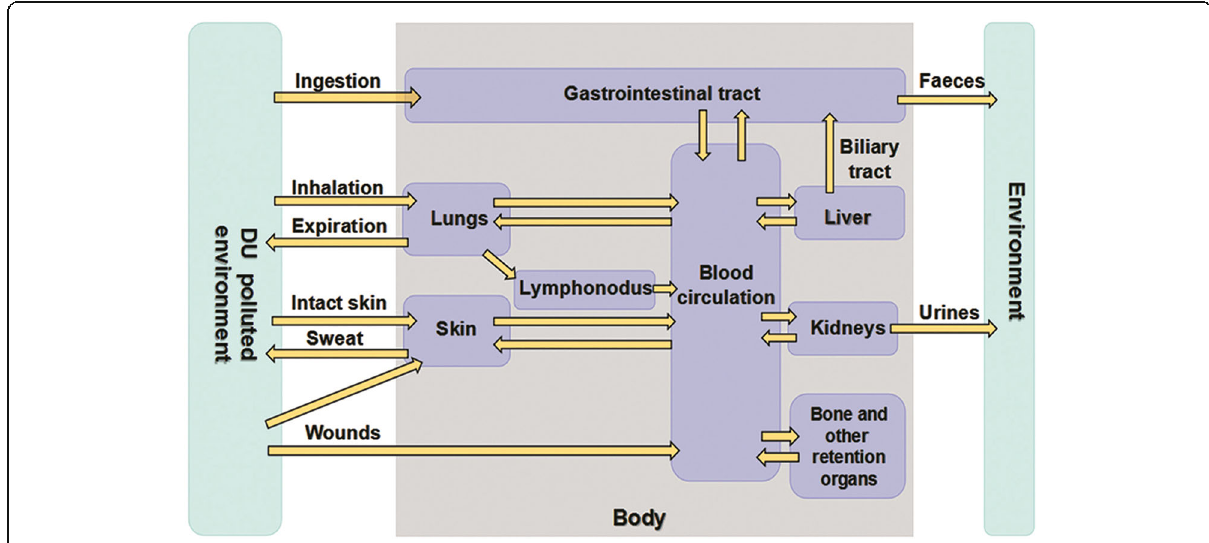
Fig. 1 Biokinetic process of DU